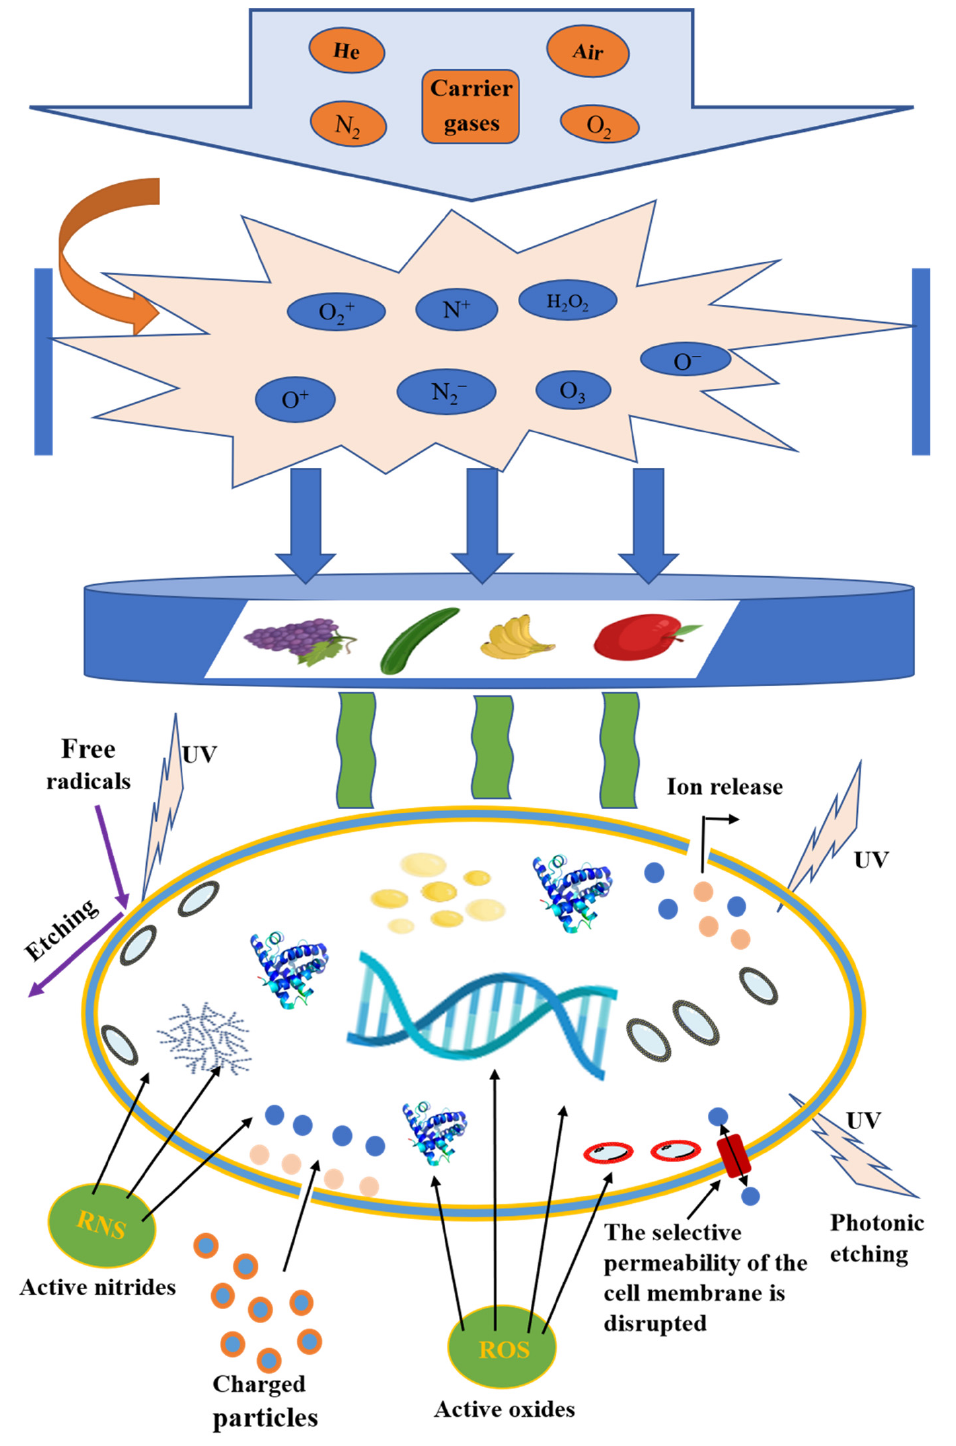
Figure 1. The generation process and action mechanism of plasma.